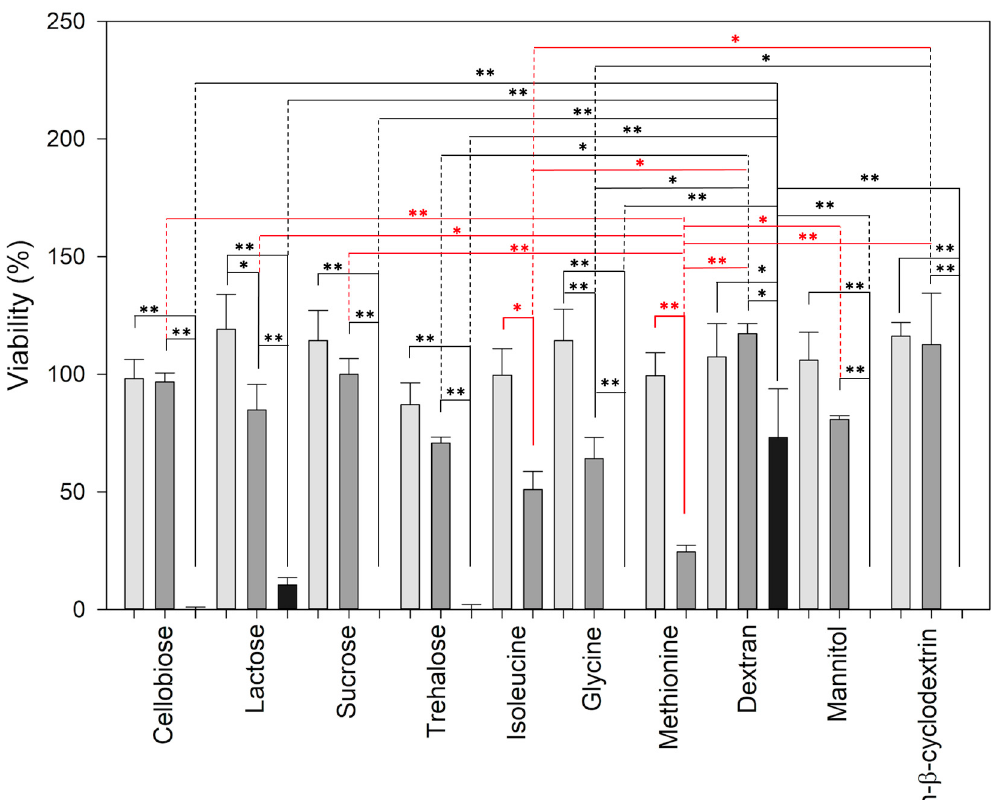
Figure 3. The graph represents the viability of Daudi after 24 h of treatment with the different excipients. Light grey is 1 mg/mL, dark grey is 10 mg/mL, and black is 100 mg/mL. Data are displayed as mean ± SE. ** for p ≤ 0.001 and * for p ≤ 0.05. Black asterisks represent the comparison of excipients at the three concentrations, without isoleucine and methionine; red asterisks represent excipients at 10 and 1 mg/mL.